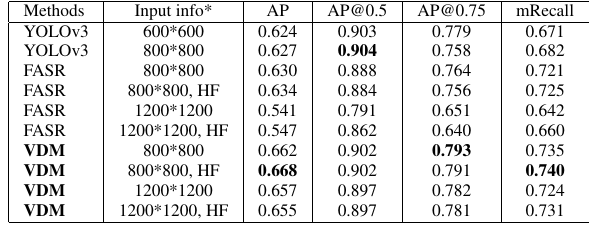
Table 6. Results on Potsdam dataset